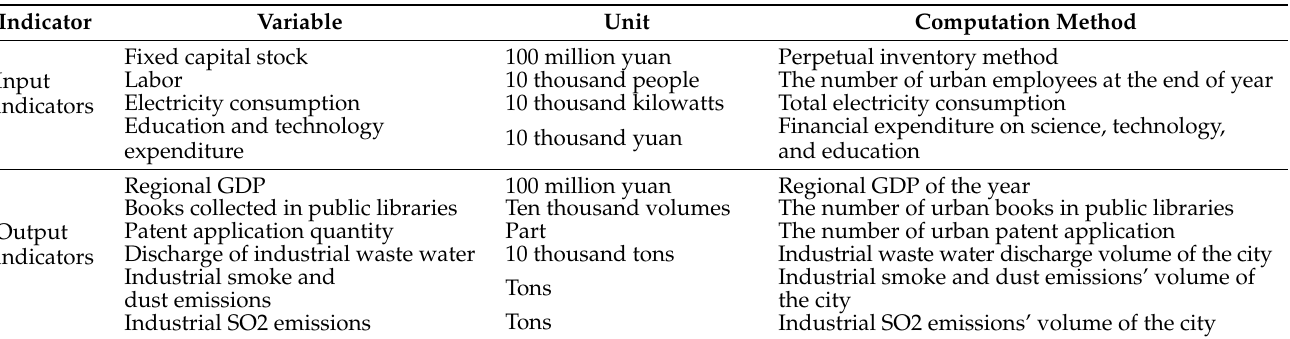
Table 1. Construction of input and output